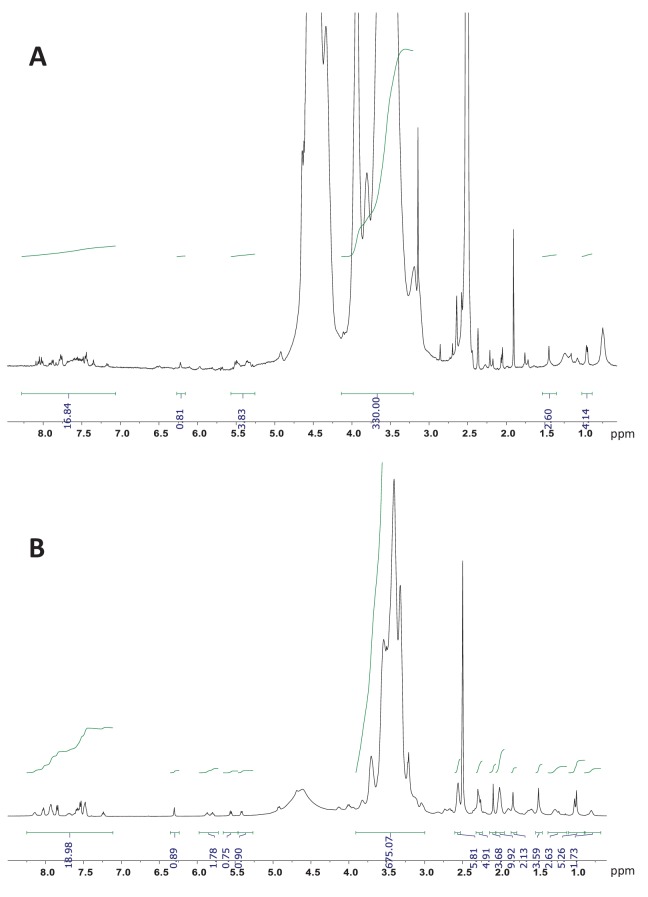
1H NMR (700 MHz, DMSO-d6) of dPGS-PTX and dPG-PTX nanoconjugates.(A) dPGS-PTX. (B) dPG-PTX. The integration of the aromatic peaks of PTX-Bz (19 hr) between 8.2–7.0 and the peaks corresponding to the dendritic backbone gives a molar ratio drug/conjugate of approximately 1.